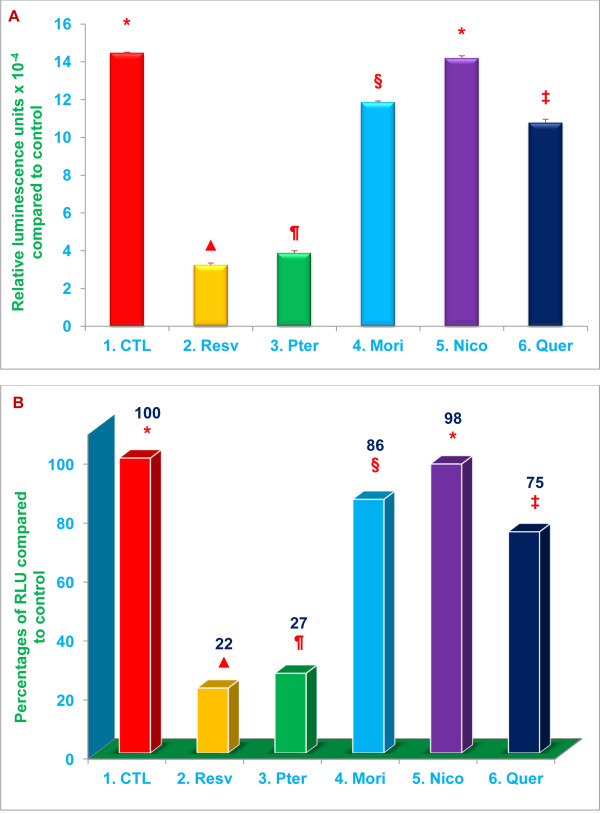
Resveratrol, pterostilbene, morin hydrate, and quercetin inhibit post-glutamase proteasomal activity. Relative post-glutamase activity was quantitated by measuring luminescence after treatment of RAW 264.7 whole cells (1x104 cells/well) with 20 μM of resveratrol, pterostilbene, morin hydrate, nicotinic acid, quercetin or medium alone (control). Cell viability exceeded 95 % in all the treatments. Data are means ± SD, n = 3 per-treatment, and triplicate analyses of each sample were performed. Values in a column not sharing a common symbol are significantly different at P <0.05. CTL = Control (Medium + RAW 264.7 whole cells + 0.2 % DMSO); Resv = resveratrol; Pter = pterostilbene; Mori = morin hydrate; Nico = nicotinic acid; Quer = quercetin-HCL. Figure A = actual relative luminescence unit (RLU) values. Figure B = Percentages of actual RLU values compared to control.